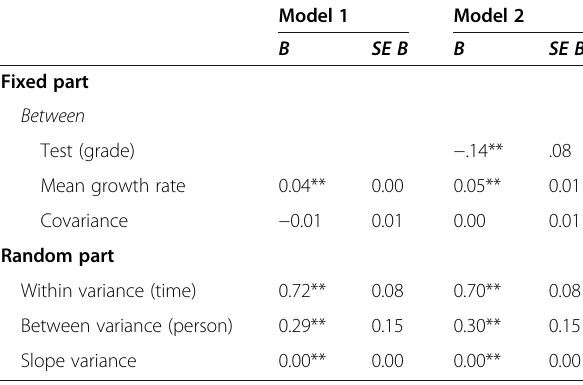
Table 2 Random slope model for pre-service teachers ’ negative emotions (states) over